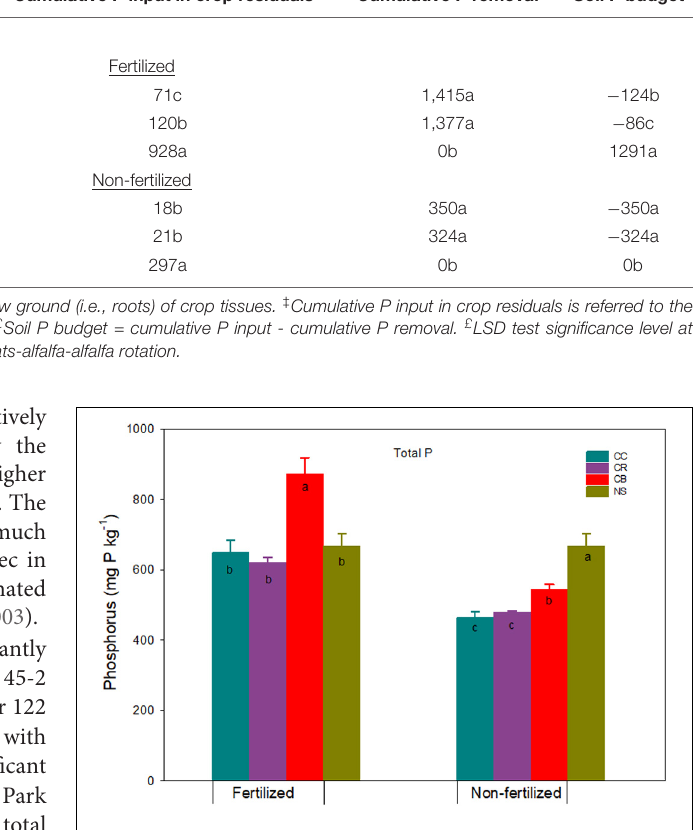
FIGURE 1 | Total P and standard errors ( n = 3) (mg kg − 1 ) in a Brookston clay loam at Woodslee, ON, Canada, after 45-year consistent cropping with and without P fertilization relative to its native forest soil (NS). CC, continuous corn; CB, continuous bluegrass sod; CR, corn-oats-alfalfa-alfalfa rotation. Letters